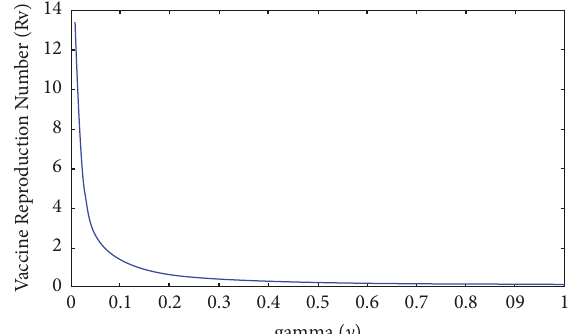
Figure 4: Plot of the vaccine reproduction number R rate of vaccination ( c ) .